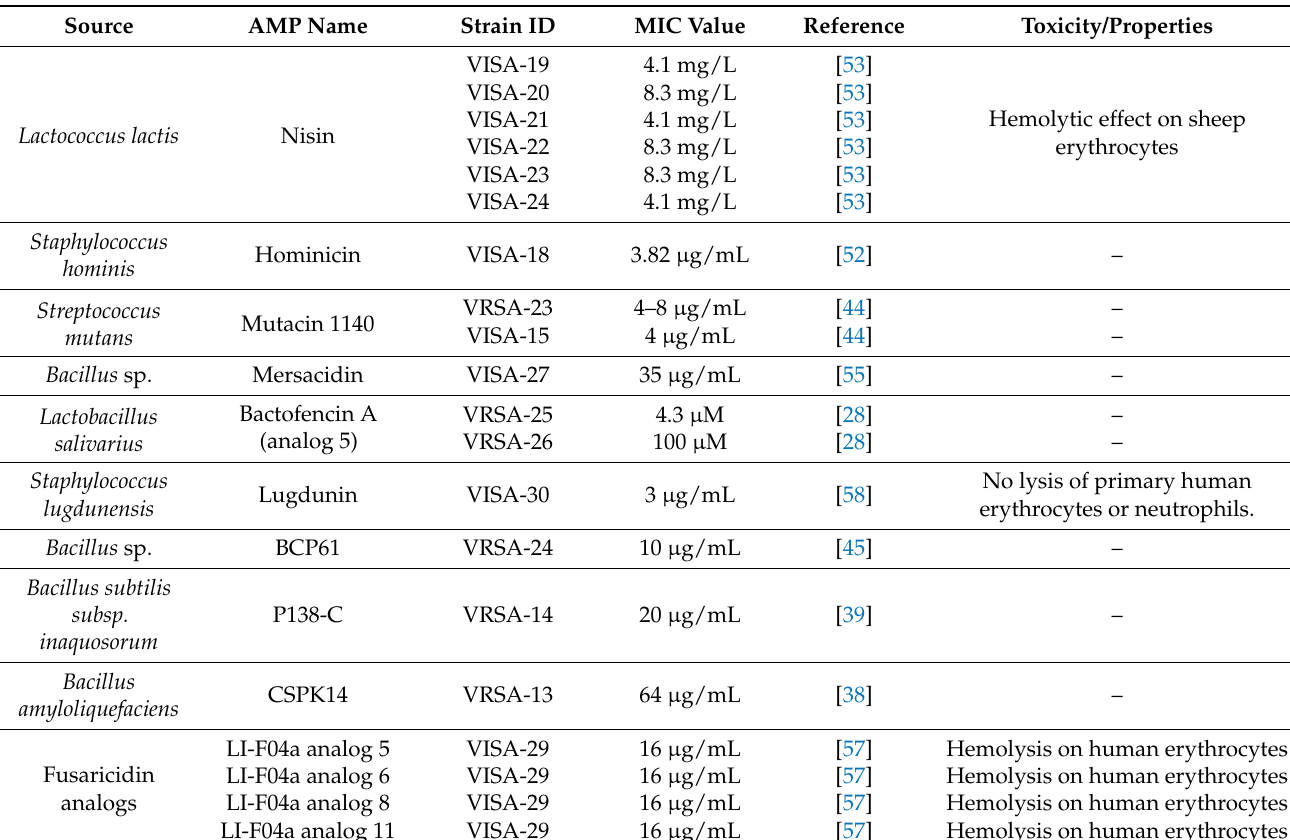
Table 3. Bacteria-derived AMPs with antibacterial activity against VRSA and VISA